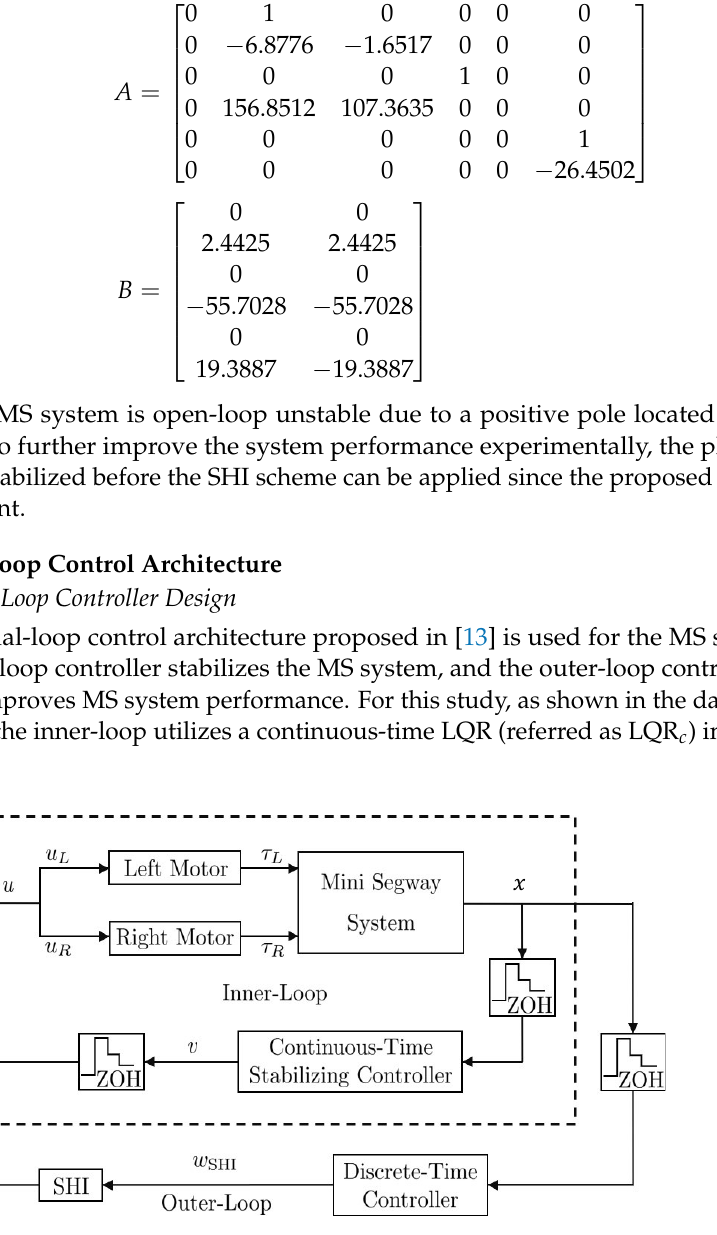
Figure 3. Dual-loop control architecture for the MS